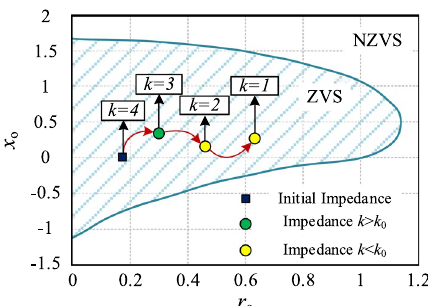
Fig. 8 Equivalent impedance movement track corresponding to the number of ON